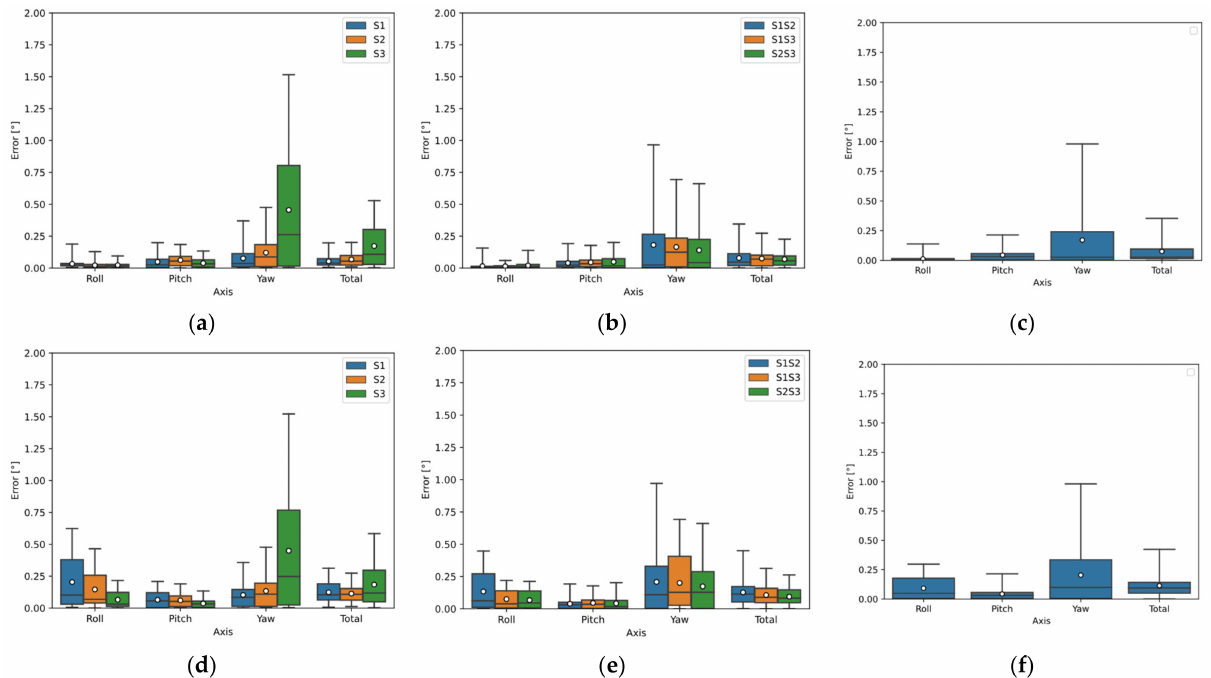
Figure 6. Object B orientation detection error by simulation using Open3D and PCL library: ( a ) sen- sors separately (Open3D); ( b ) two sensors configuration (Open3D); ( c ) three sensors configuration (Open3D); ( d ) sensors separately (PCL); ( e ) two sensors configuration (PCL); ( f ) three sensors config- uration